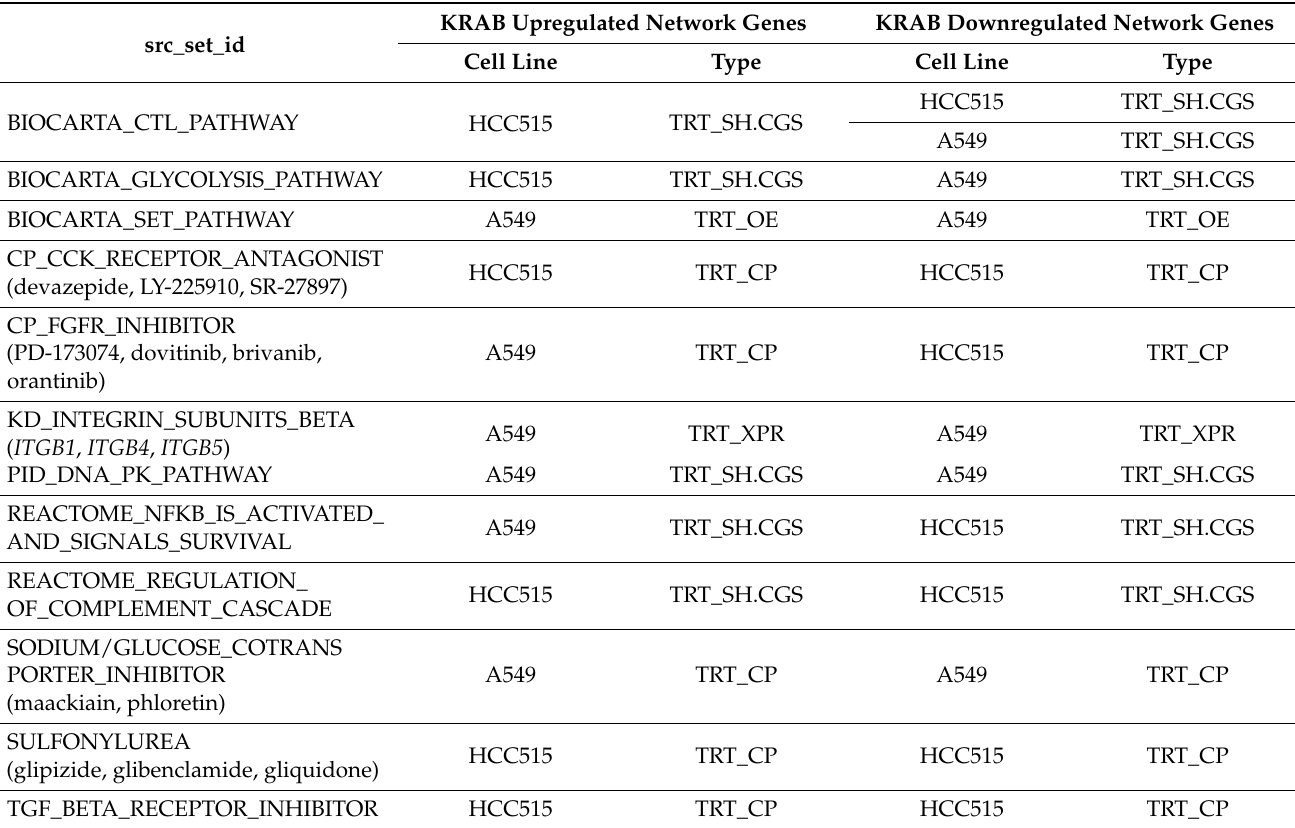
Table 4. The common significant ( p < 0.05, connectivity score > 0.9) functional pathways from CMap using ZNF71 KRAB upregulated network genes (Figure 5C) and ZNF71 KRAB downregulated network genes (Figure 5D) as input.